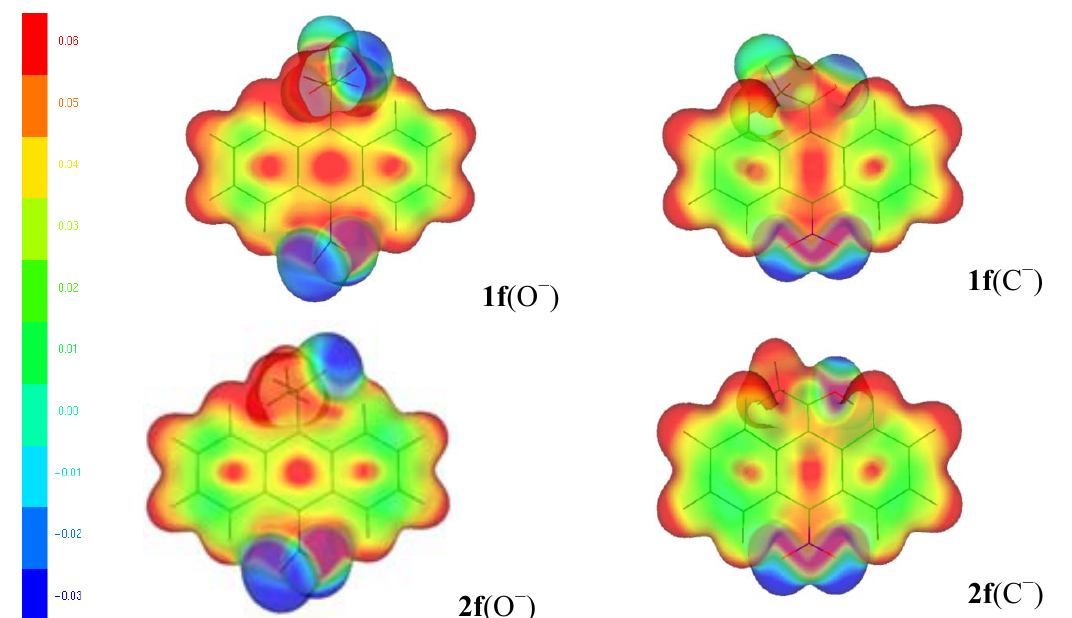
Figure 7. MEP mapped onto an isosurface of the total electron density for the alkoxides (O − ) and carbanions (C − ) of 1f and 2f